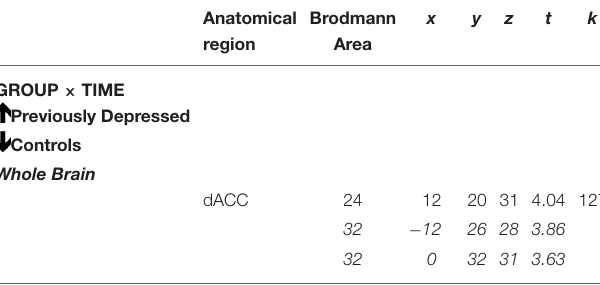
Effects are significant at p < 0.05 corrected. Montreal Neurological Institute coordinates; coordinate in italics connote peaks within a same cluster; dACC, dorsal anterior cingulate